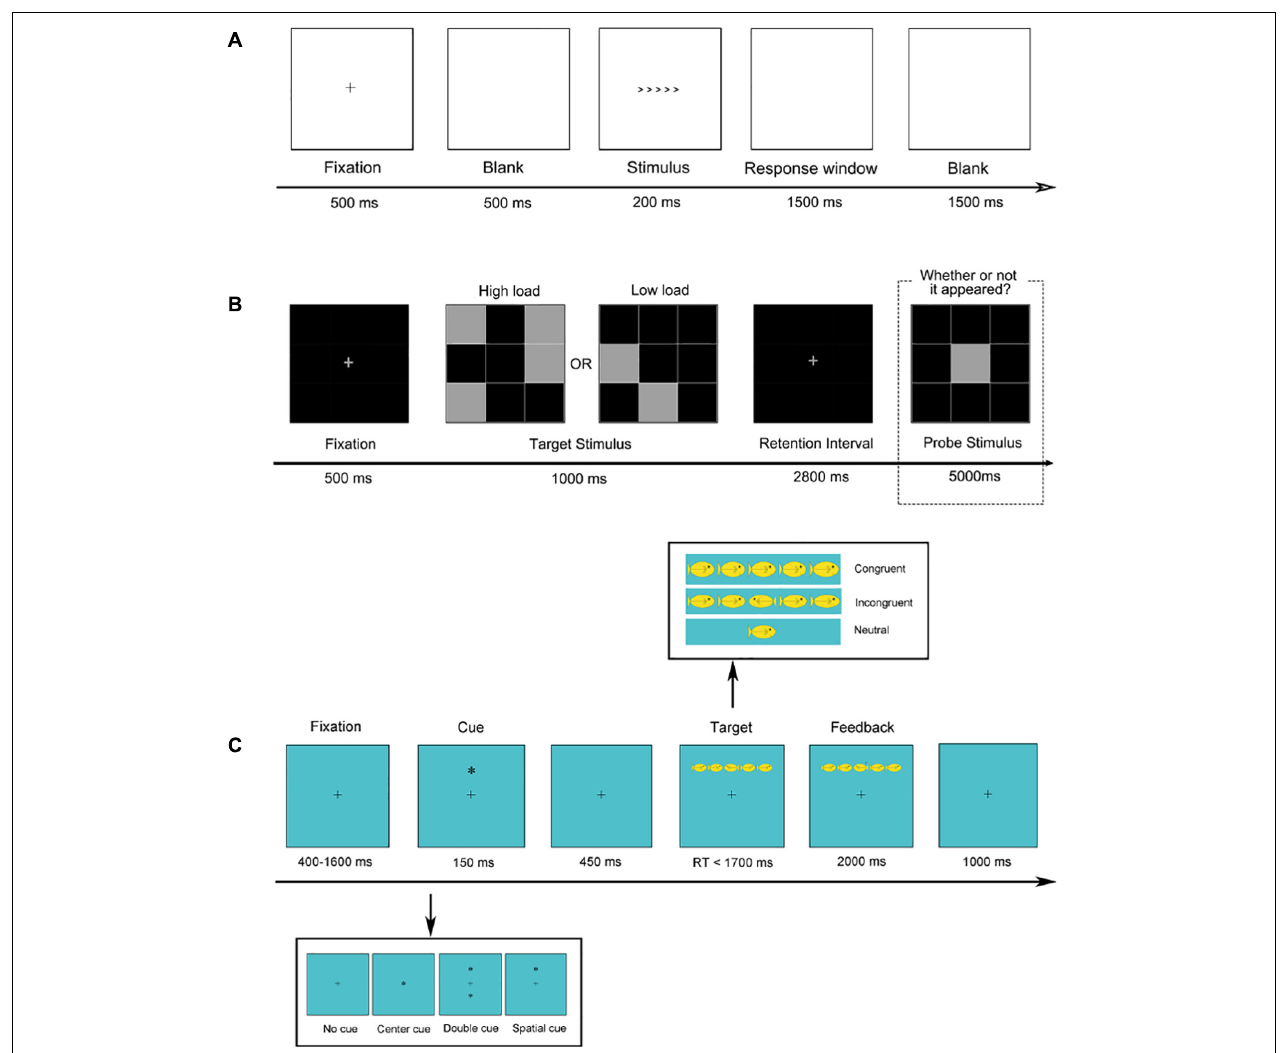
FIGURE 2 | The flowchart of the experimental paradigms. (A) The flanker task. (B) Visual delayed match-to-sample task. (C) Attention network